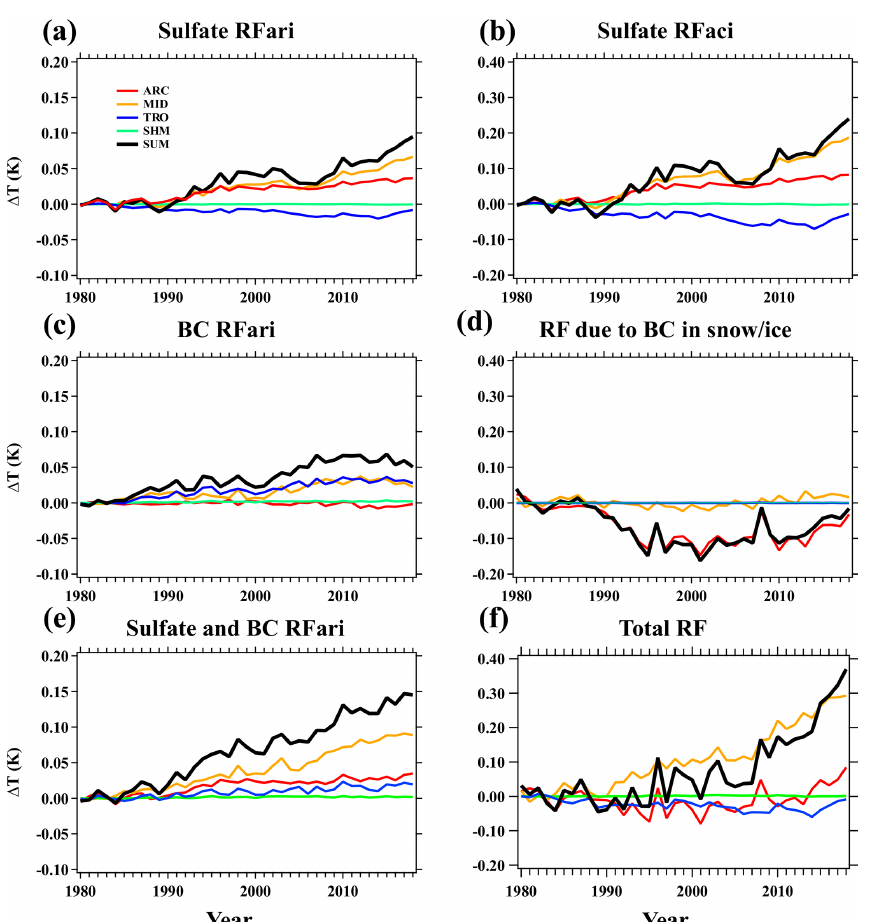
Figure 11. Time series (1980–2018) of the estimated response in surface temperatures (K) to the change in radiative forcing due to the aerosol–radiation interactions (RF ari ) of (a) sulfate, (c) BC, and (e) sum of sulfate and BC RF ari ; (b) radiative forcing due to aerosol–cloud interactions (RF aci ) of sulfate, (d) radiative forcing (RF) due to BC in snow and ice, and (f) the sum of all RF in each latitudinal band and the sum of them